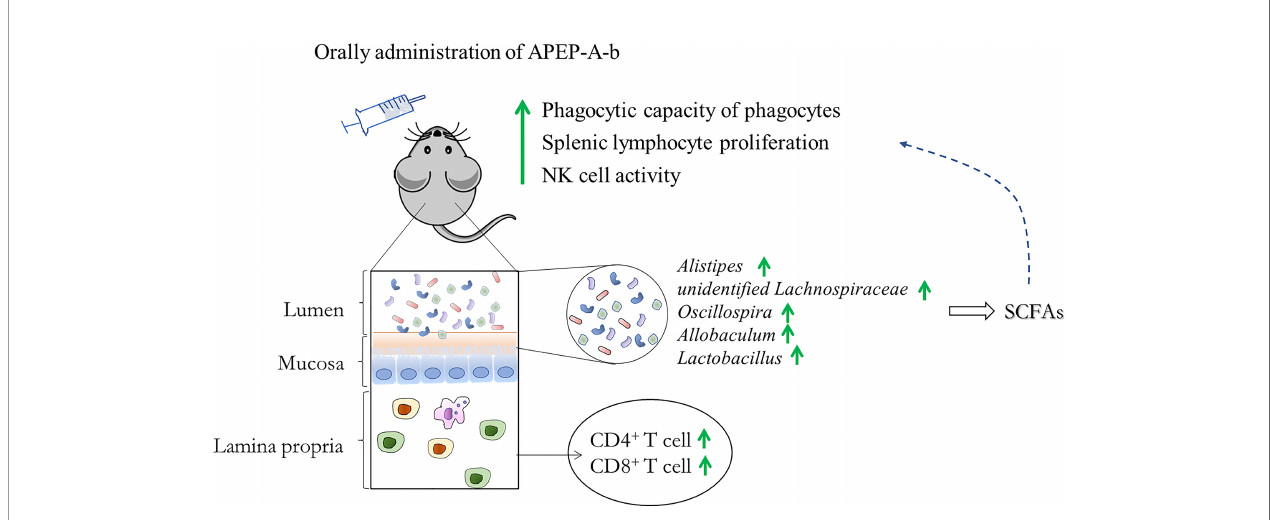
FIGURE 8 | A likely mechanism for the immune regulatory effect from